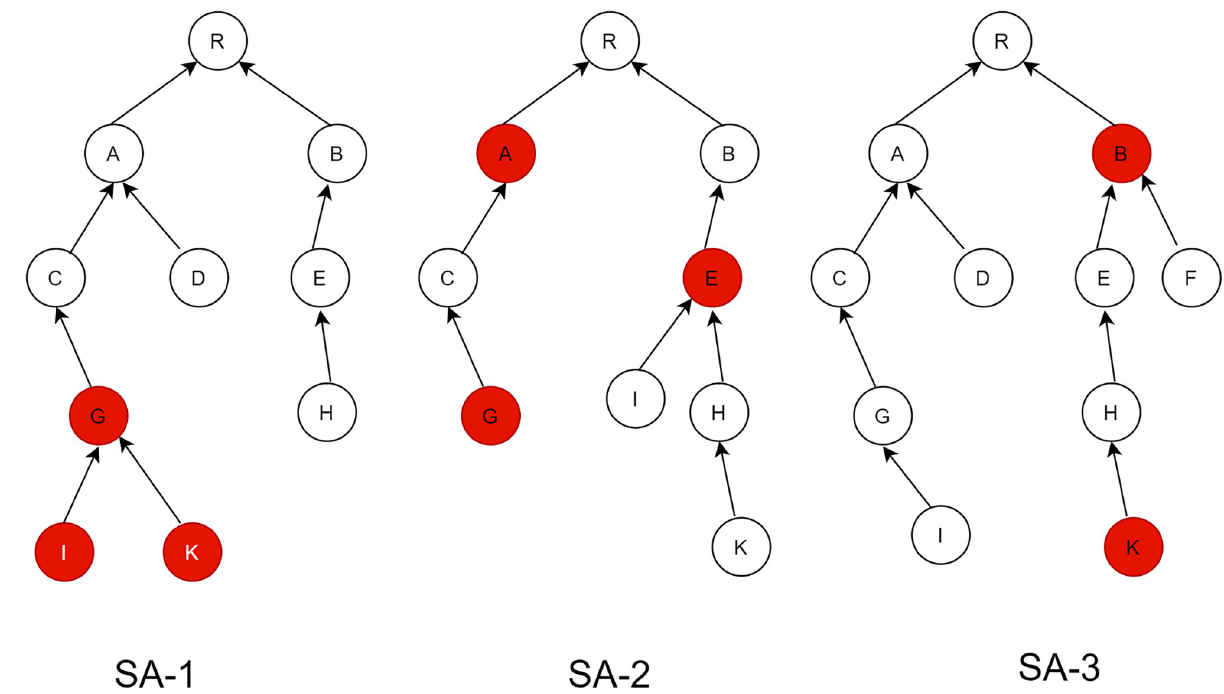
Fig 9. Trust computation